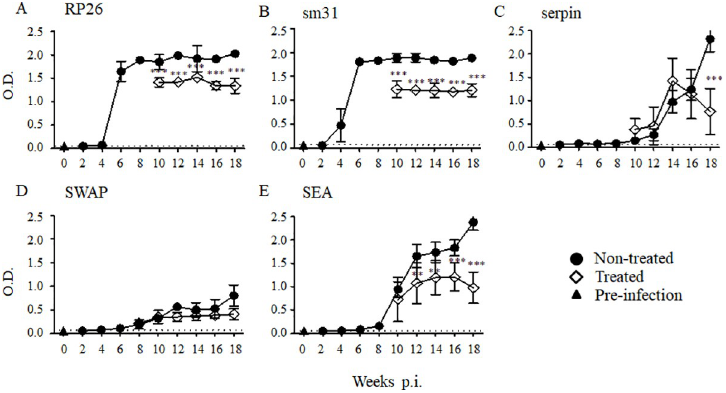
Fig 3. IgG1 responses to the S . mansoni antigens RP26, sm31, serpin, SEA and SWAP during S . mansoni infection and after the treatment. Five mice were infected with 50 S . mansoni cercariae, and the sera were collected from five mice at each time point. A group of mice was orally treated twice with 500 mg/kg PZQ at 8 weeks post-infection. The experiment was repeated for 3 times and the representative data are presented. The means of the IgG1 level to the S . mansoni recombinant RP26 (A), sm31 (B), serpin (C), and crude SWAP (D) and SEA (E) are shown with the standard errors. The dashed line represents the cut-off value (mean + 3SD of the OD of the pre-infected group). IgG1 levels of the treated group (open diamonds) were compared with those of the untreated group (closed circles) and with those of pre-infection samples taken at week 0 (closed triangles). �� p < 0.01 and ��� p < 0.001.